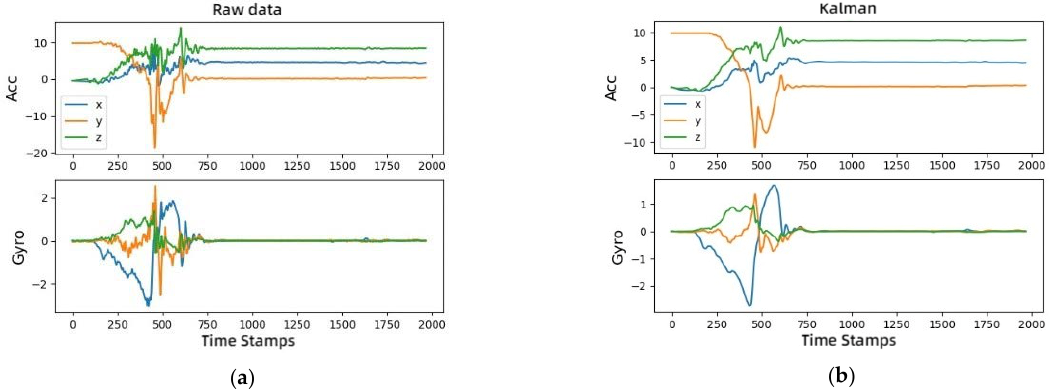
Figure 5. ( a ) Acceleration and angular velocity before Kalman filtering; ( b ) acceleration and angular velocity after Kalman filtering.